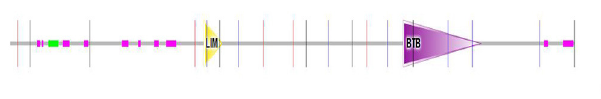
FIGURE 3 | Domains within Drosophila melanogaster protein Radish. Yellow triangle box represents the LIM domain region, the LIM domain of Radish was located at positions 568 to 622 amino